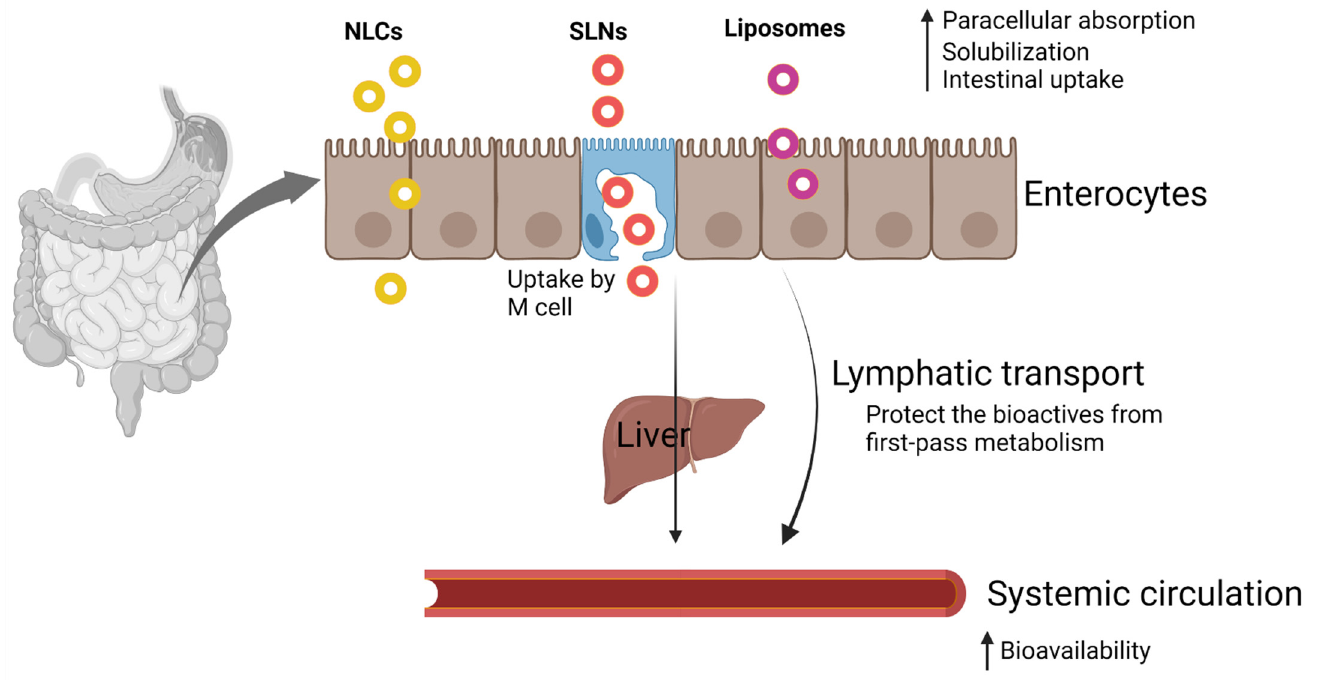
Figure 1. Transport mechanism of nanosized lipid-based delivery systems (created with Biorender.com). Paracellular absorption: Orally administered nutraceuticals must reach the systemic circulation via absorption through the intestinal epithelial layer. There are four different transfer mechanisms: paracellular, transcellular, carrier-mediated, and receptor-mediated transport. Paracellular absorption refers to the transport of molecules between adjacent epithelial cells, but the rate-limiting step in this absorption process is the transport across the tight junction [17]. The intestinal epithelium is one of the major barriers to the absorp- tion of hydrophilic bioactive molecules due to the nondiffusional properties of epithelial cells through lipid bilayer cell membranes to the bloodstream [18]. Ji, et al. [19] enhanced the solubility and bioavailability of curcumin by solid lipid nanoparticle formulation with